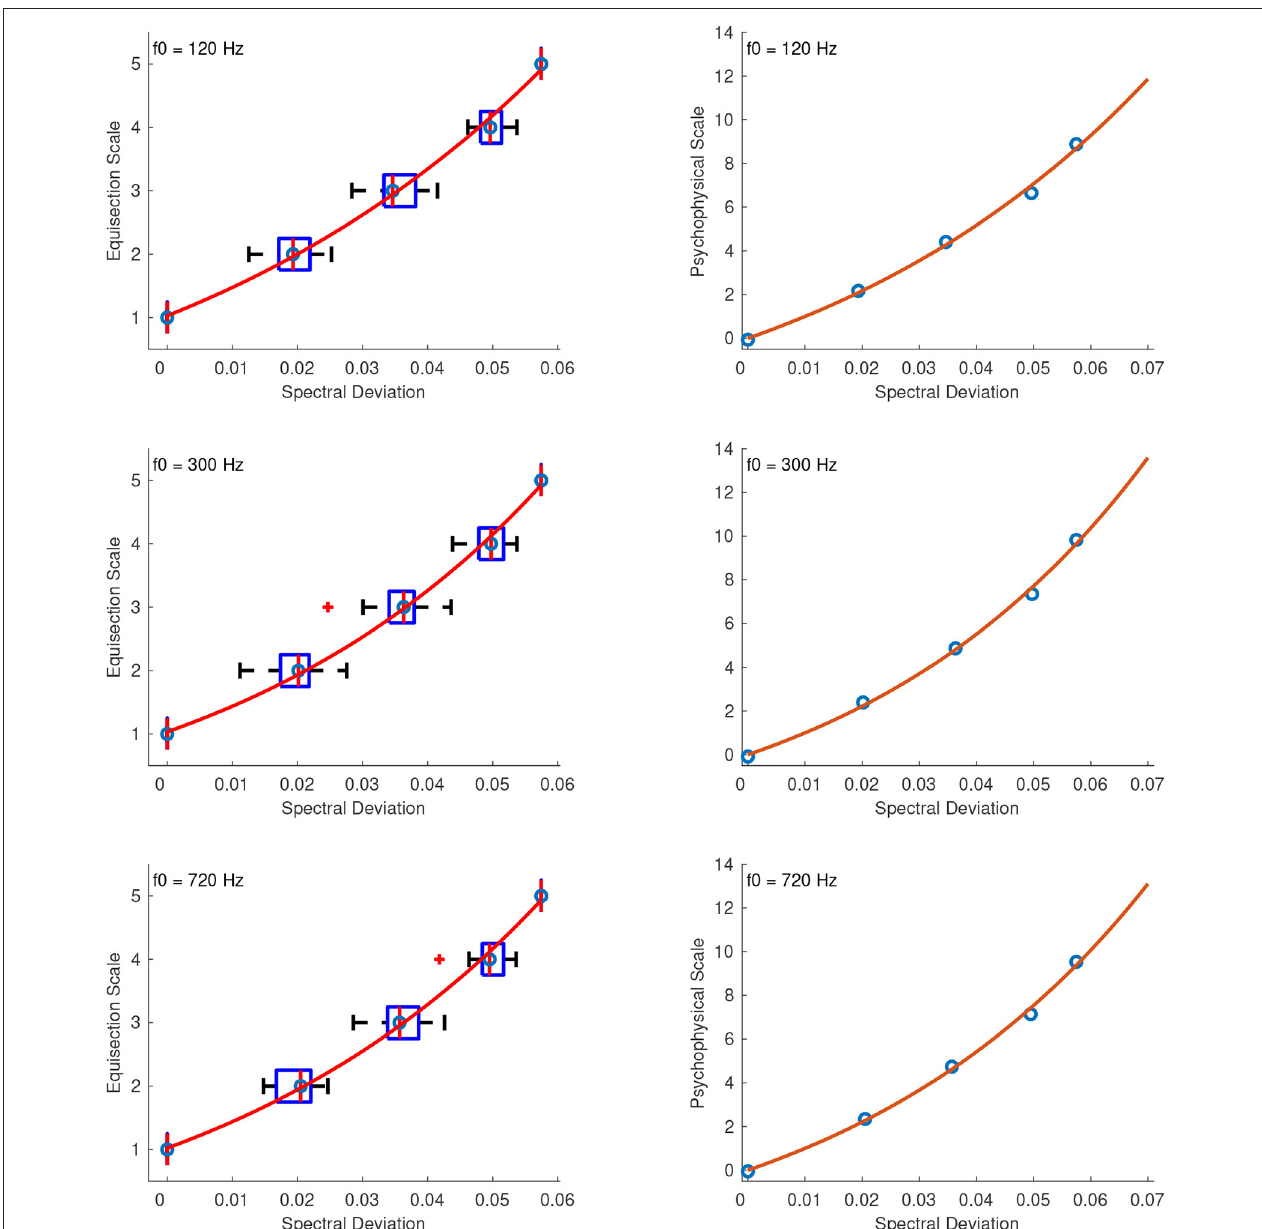
FIGURE 13 | Equisection and psychophysical scales of spectral deviation at three f0s. Left panel, boxplots and fitting function on the median ratings. Whiskers extend to 2.7 SD; Right panel, psychophysical scale and extrapolated fitting